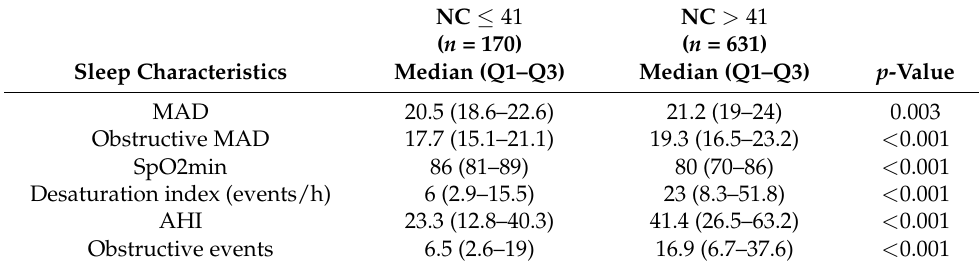
Table 6. Comparison between sleep characteristics of patients with neck circumference NC ≤ 41 cm and patients with NC above this cutoff point; the p-values were obtained with the Mann–Whitney U tests and are presented as median (1st quartile–3rd quartile; quartiles obtained with Turkey’s method). Q1 = 1st quartile, Q3 = 3rd quartile, MAD = mean apnea duration, AHI = apnea–hypopnea index, Obstructive MAD = Obstructive mean apnea duration, SpO2min = minimum oxygen desaturation. NC ≤ 41 NC > 41 ( n = 170) ( n = 631) Sleep